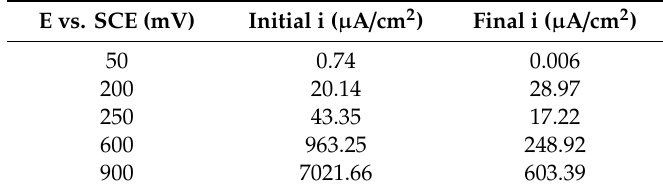
Table 1. The initial and final current densities during 3-h polarizations.